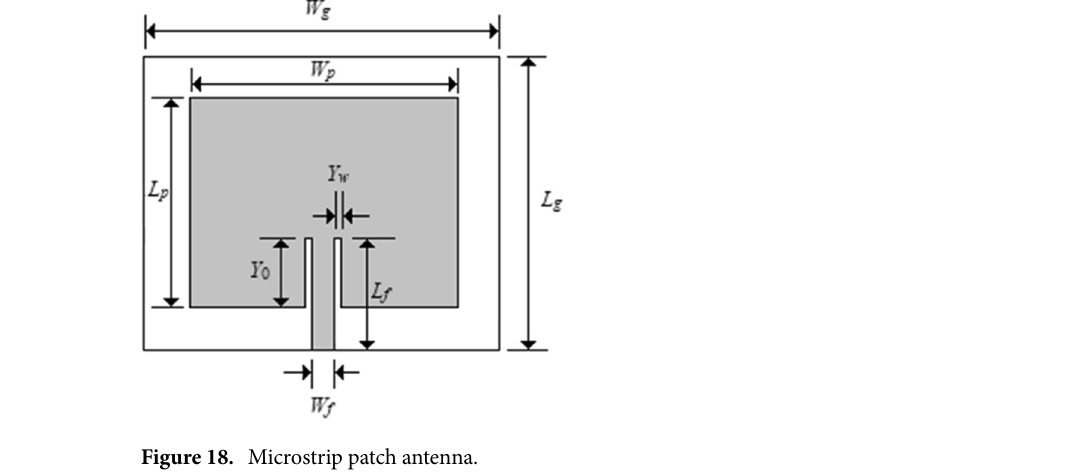
Figure 18. Microstrip patch